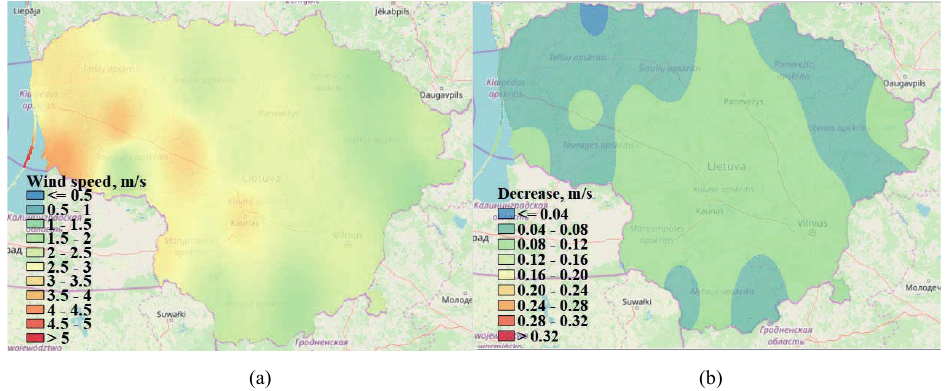
Fig. 3. (a) Climatological normal (1980 – 2010) of wind speed in Lithuania, and (b) the change of wind speeds over the last decade (2010– 2019)